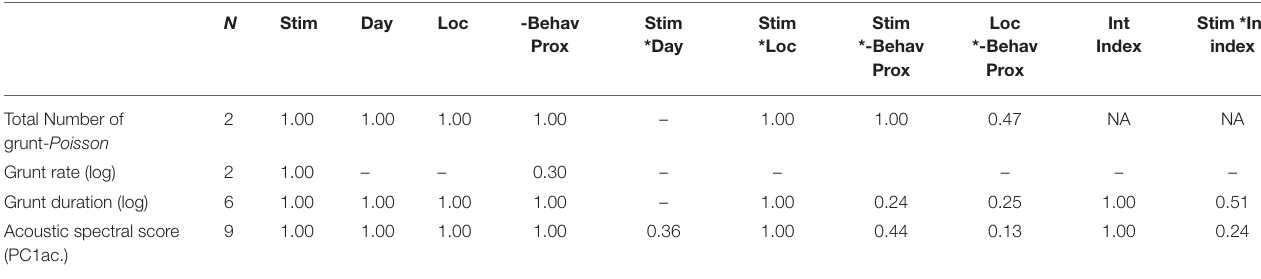
TABLE 7 | Weight of predictors for each response